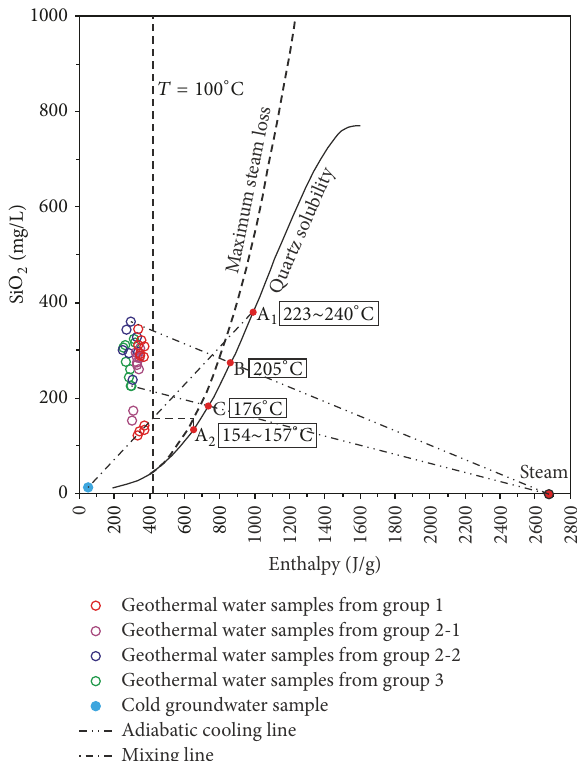
Figure 7: Silica-enthalpy mixing models of geothermal spring samples in the research